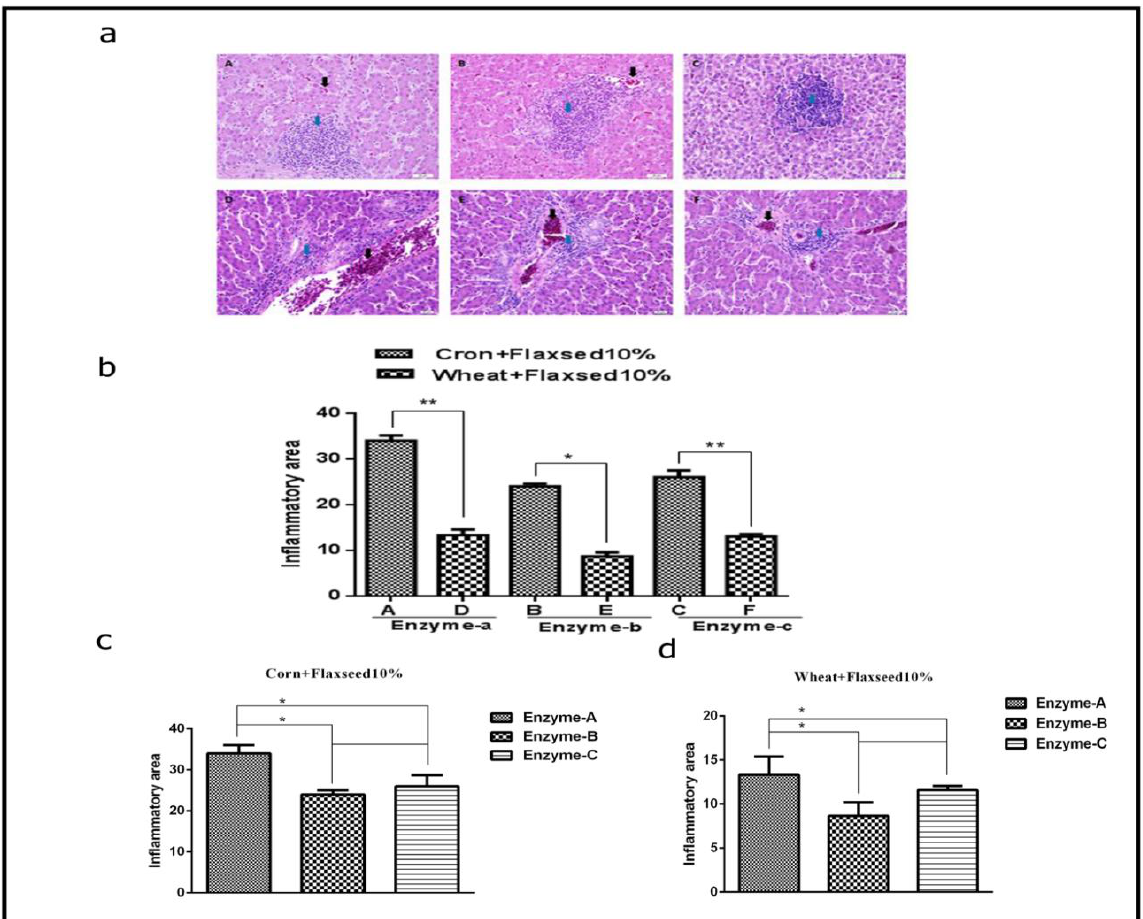
Figure 3. The effects of corn and wheat diet supplemented with 10% flaxseed and enzyme on the histopathology of liver tissues of lying birds. Corn and wheat diets were formulated with 10% flaxseed and 3 different multi-carbohydrase enzymes, as indicated in Table 1. ( a ) Representative images of H&E stained liver sections of various diet-fed birds. Inflammatory cells are marked with blue arrows, while black arrows show the accumulation of RBCs in the liver tissue. ( b ) Percent area occupied by various inflammatory cells in the liver tissue of various diet-fed bird groups. Birds fed the corn diet + 10% flaxseed supplemented with (A) enzyme-a, (B) enzyme-b and (C) enzyme-c ( n = 6). Birds fed with wheat diet + 10% flaxseed supplemented with (D) enzyme-a, (E) enzyme-b and (F) enzyme-c ( n = 6); Image J software was used for the analyses of % inflammatory area in the liver tissue of birds fed with ( c ) corn diet + 10% flaxseed and ( d ) wheat diet + 10% flaxseed. Data are expressed as mean ± SD, scale bar 20 µm. Data is expressed as mean ± SEM. ( c , d ) * p < 0.01, ** p < 0.001.